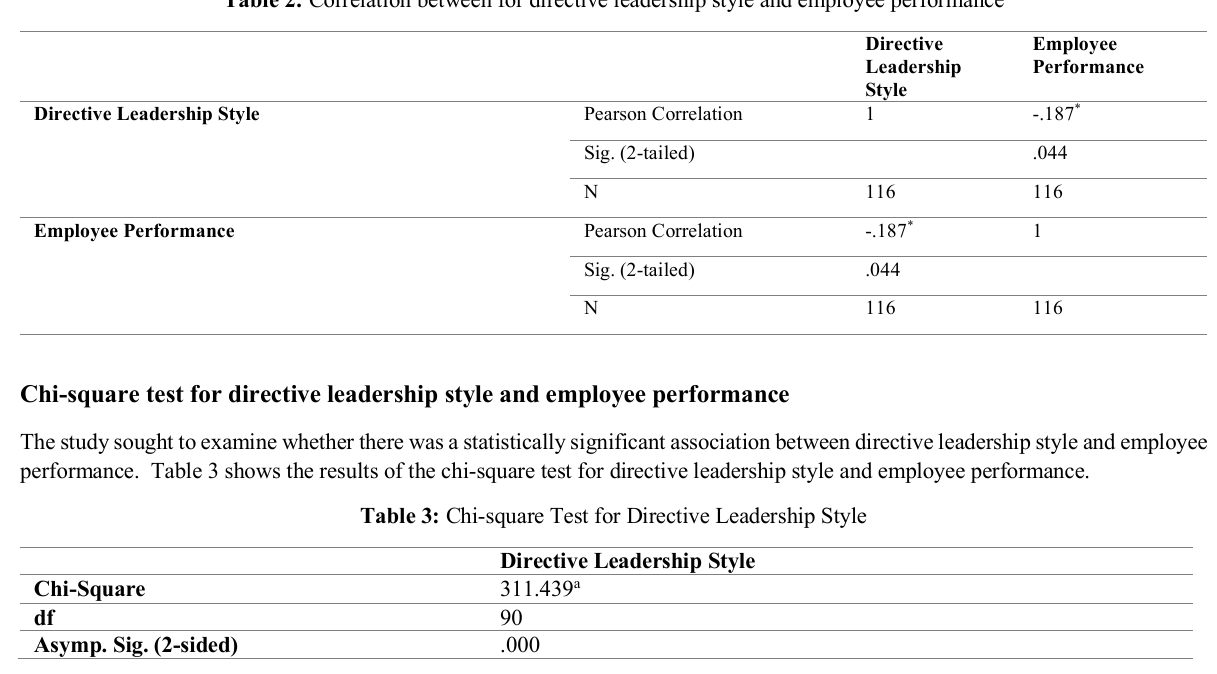
Table 2: Correlation between for directive leadership style and employee performance